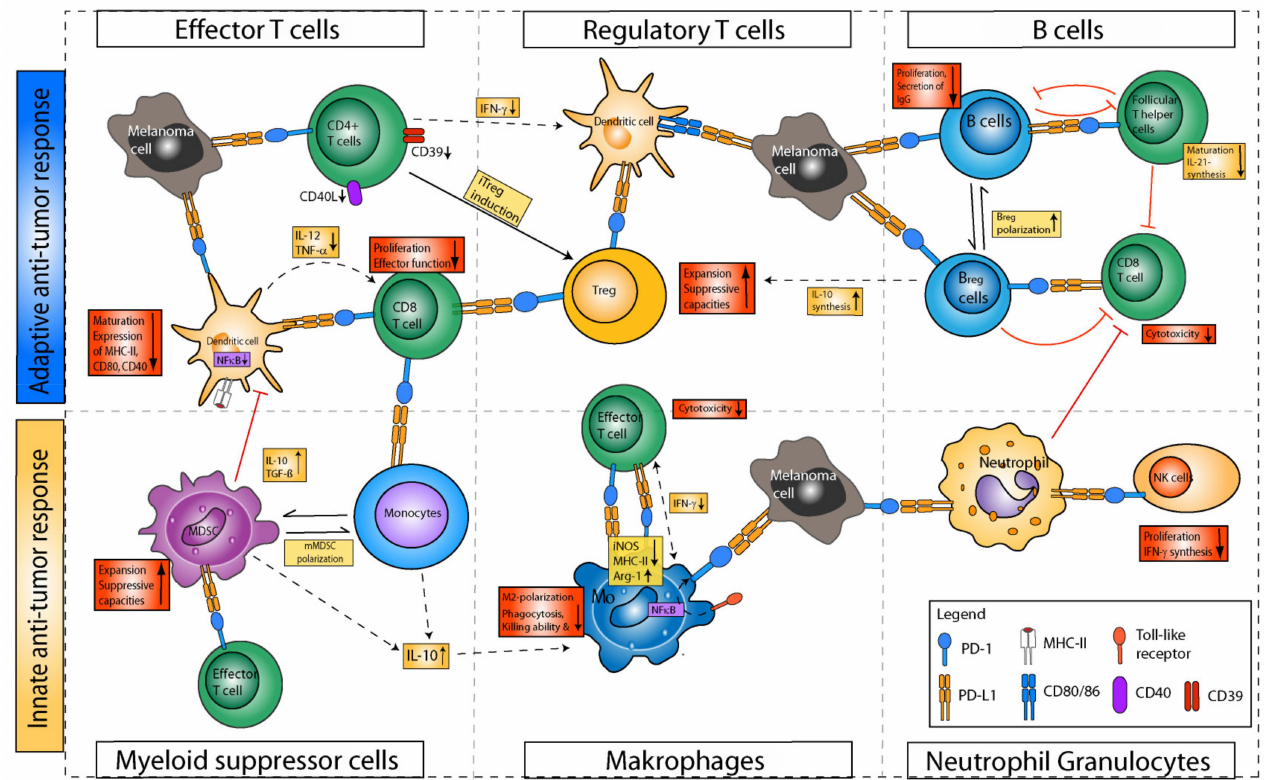
Figure 3. Immunomodulatory effects of the PD-1/PD-L1 axis. Besides CD8 + T cells, expression of checkpoint proteins PD-1 and PD-L1 has been reported on CD4 + T helper cells, regulatory T cells (Treg), B-cells, innate lymphoid cells, NK cells and various myeloid cells, such as dendritic cells (DC), macrophages, myeloid-derived suppressor-cells (MDSCs), polymorphonuclear neutrophils (PMNs) and monocytes. Overall, PD-1 expression on these immune cell types has been associated with an immunosuppressive phenotype impairing effector T cell functions, both directly, via ligand— receptor interactions, and indirectly, by creating an immunosuppressive tumor microenvironment. For the majority of studies, these observations were made particularly under the conditions of an inflammatory microenvironment. In this schematic illustration, immunosuppressive activities conferred upon ligation of PD-1/PD-L1 are illustrated in bright red, while cytokine secretions induced via PD-1/PD-L1 signaling are pictured in yellow boxes. Indirect effects of PD-1/PD-L1 ligation are shown in dashed lines, while direct effects are illustrated without